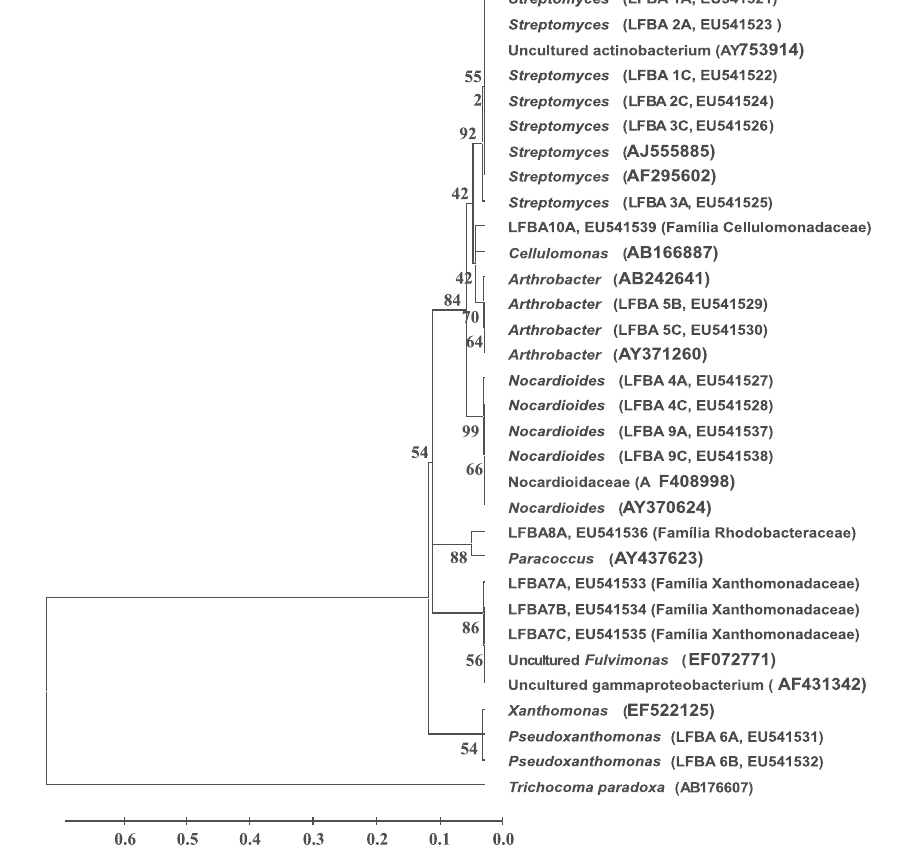
Figura 6. Árvore filogenética de isolados bacterianos degradadores de antraceno na rizosfera de plantas de crescimento espontâneo em solo de “landfarming” de resíduo petroquímico e isolados recuperados do GenBank. A pesquisa foi baseada na análise neighbor joining , construída com base de 1.000 réplicas de “ bootstrap” . Os valores mostrados na árvore são dados em percentagem de “ bootstrap” . O taxon é seguido pela sigla do isolado e, ou, de número de acesso no GenBank.